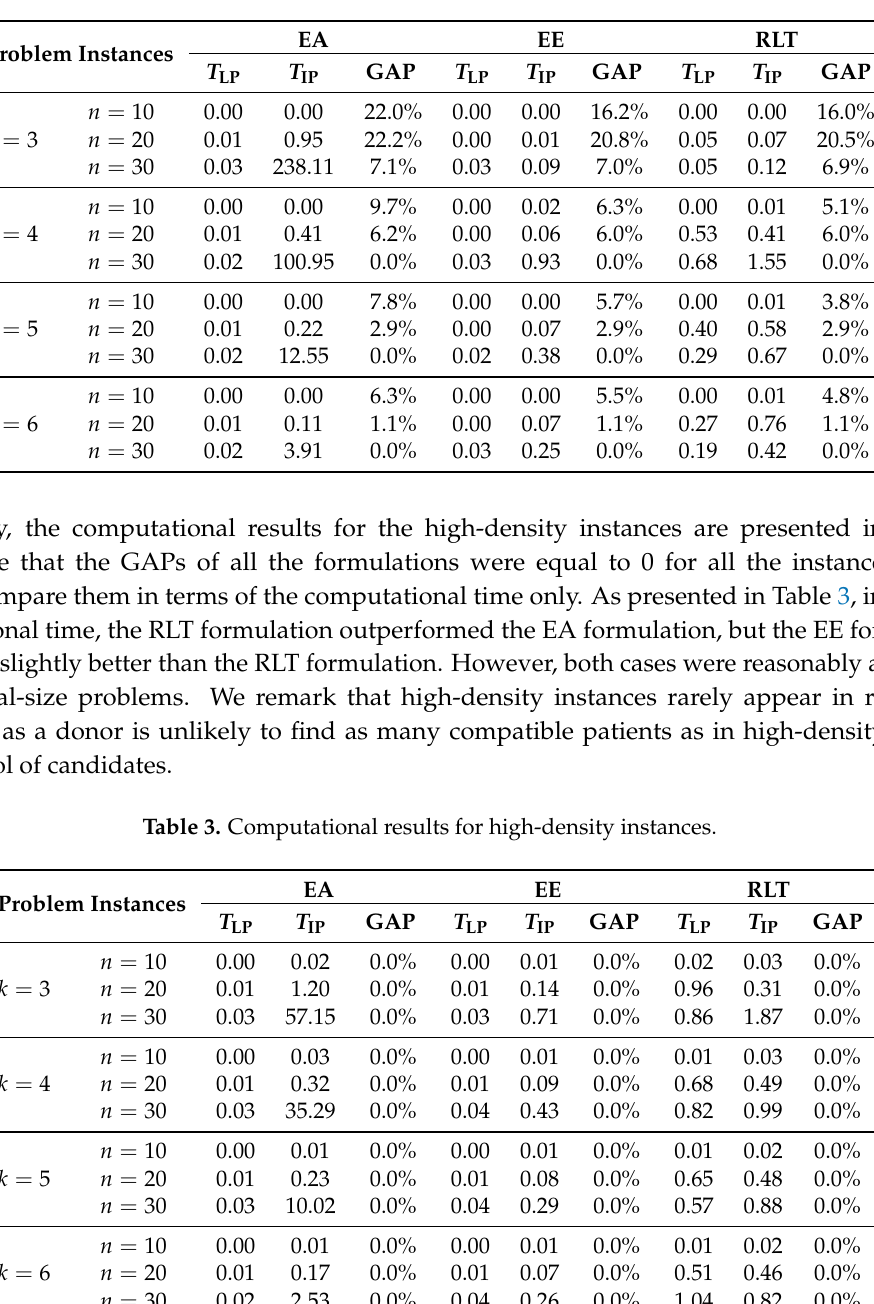
Table 2. Computational results for medium-density instances.